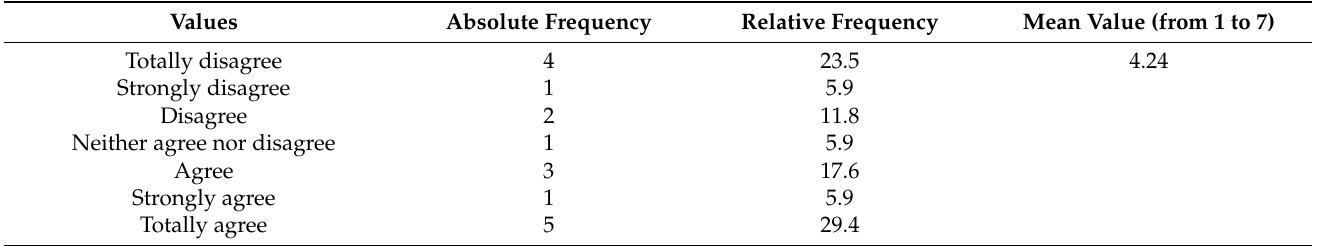
Table 2. Analysis of the results for item 2: “There are greater barriers for women than men when it comes to reaching top-level positions (reconciliation of work–life balance, time, dedication, circles of power, etc.)”.